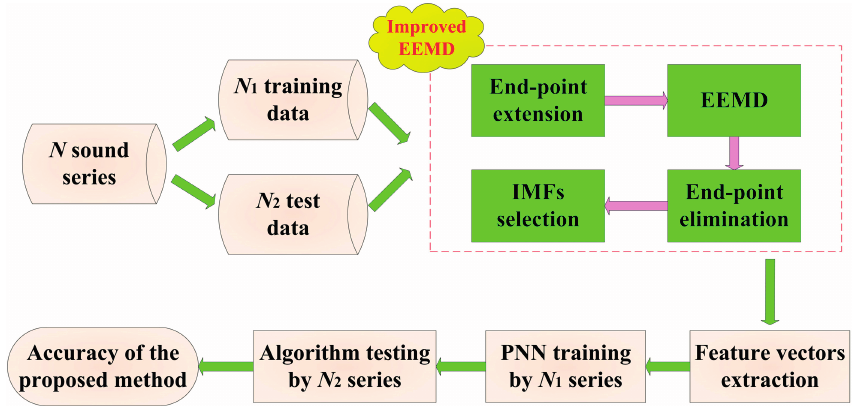
Figure 2. Flowchart of the cutting pattern recognition method based on IEEMD and PNN.